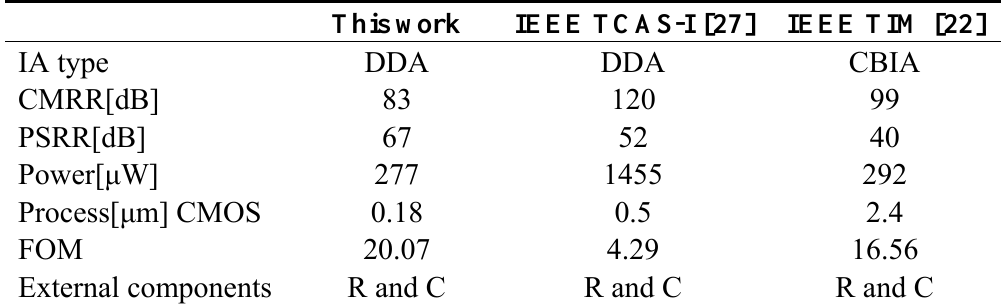
Table 1. Measured performance summary of the DDA circuit.